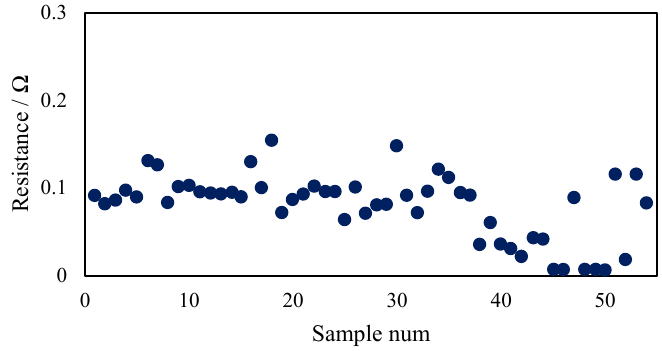
Figure 7. Resistance values of 54 s-life batteries [32].